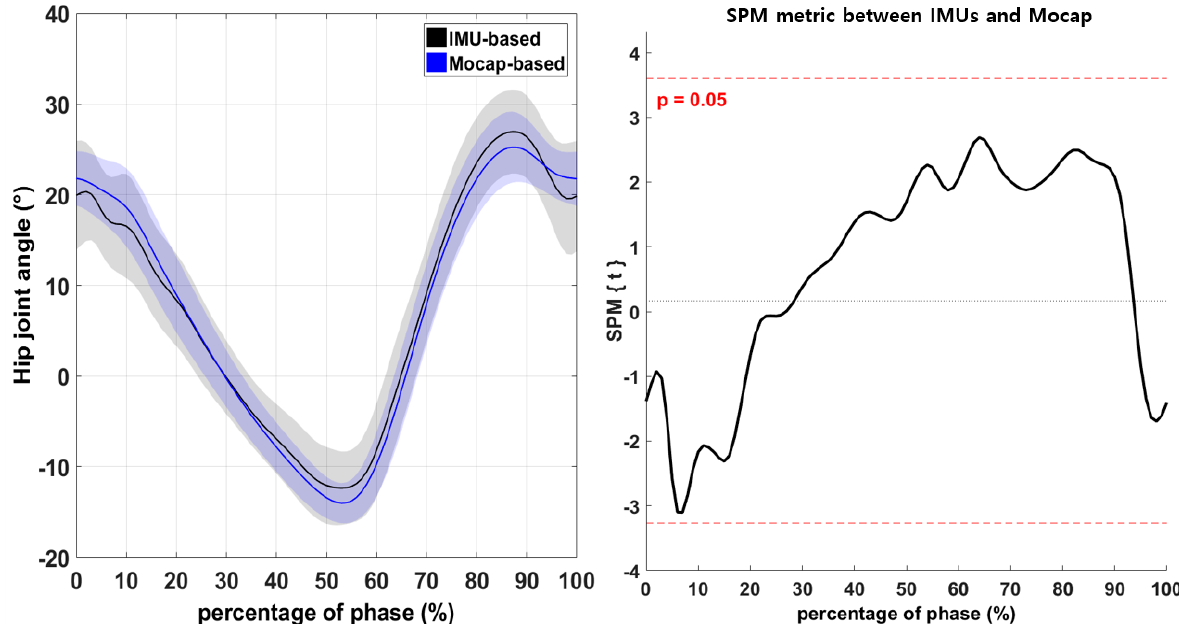
Figure 3. Comparison of the hip-joint angle between the IMU-based and Mocap systems according to one-dimensional SPM. Horizontal dashed lines illustrate significant differences at α = 0.05, and the result is visualized as a waveform.